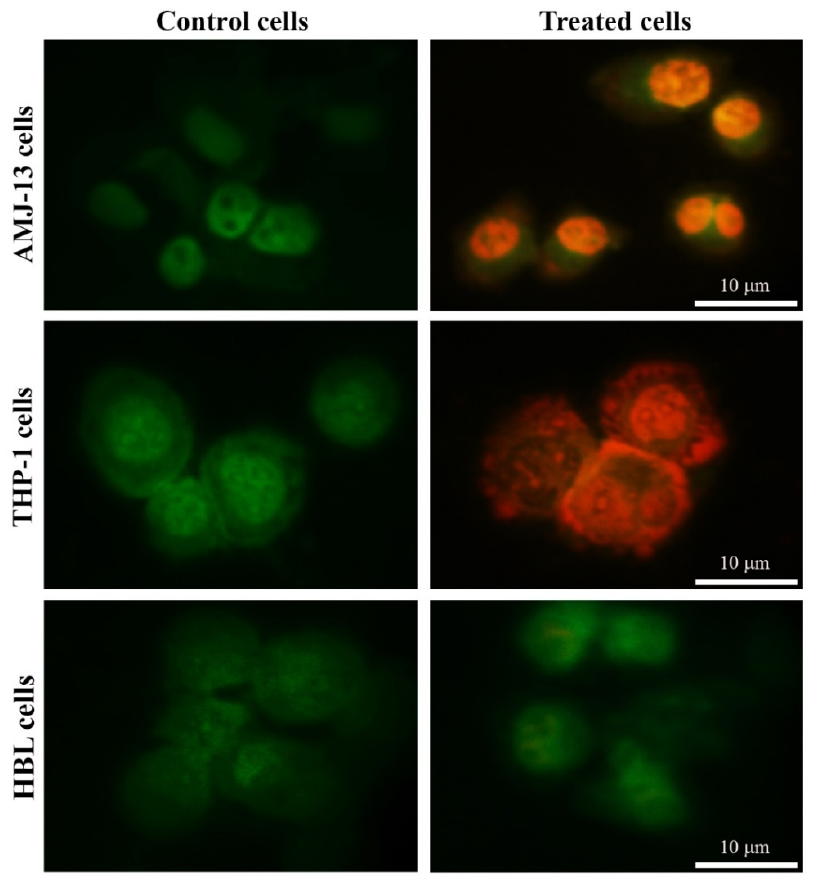
Figure 4. Apoptotic markers in AMJ-13, THP-1, and HBL cells treated with AgNPs at IC 50 ( 17.34 μ gmL − 1 ) for 24hr and stained with AO/EtBr for 1 min. Untreated cells are shown with a normal structure. However, after treatment with AgNPs, apoptotic features are observed; the red color indicates apoptosis. Scale bar 10 μ m.